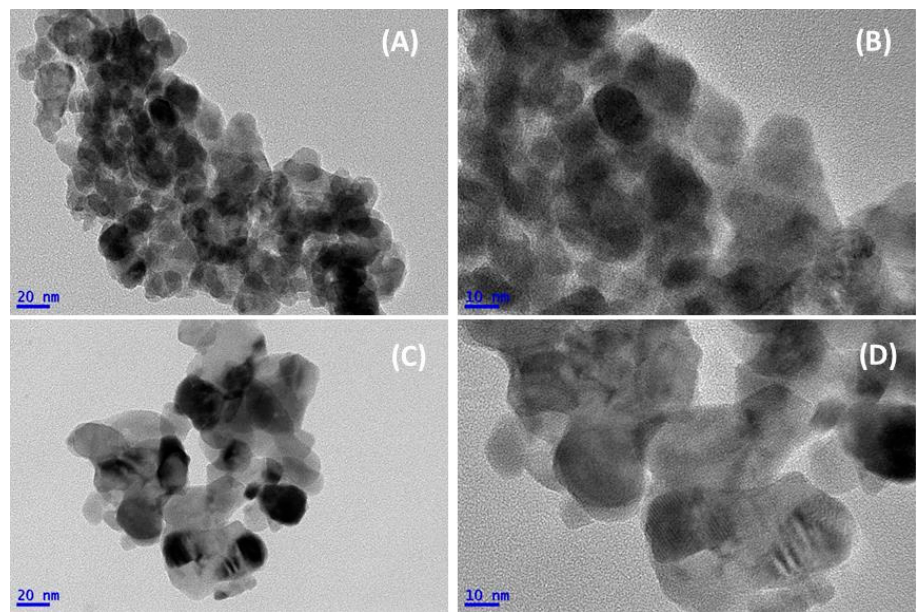
Figure 3. TEM images of BA catalyst ( A , B ), and CA catalyst ( C , D ) samples, after thermal stabilization at 500 °C.